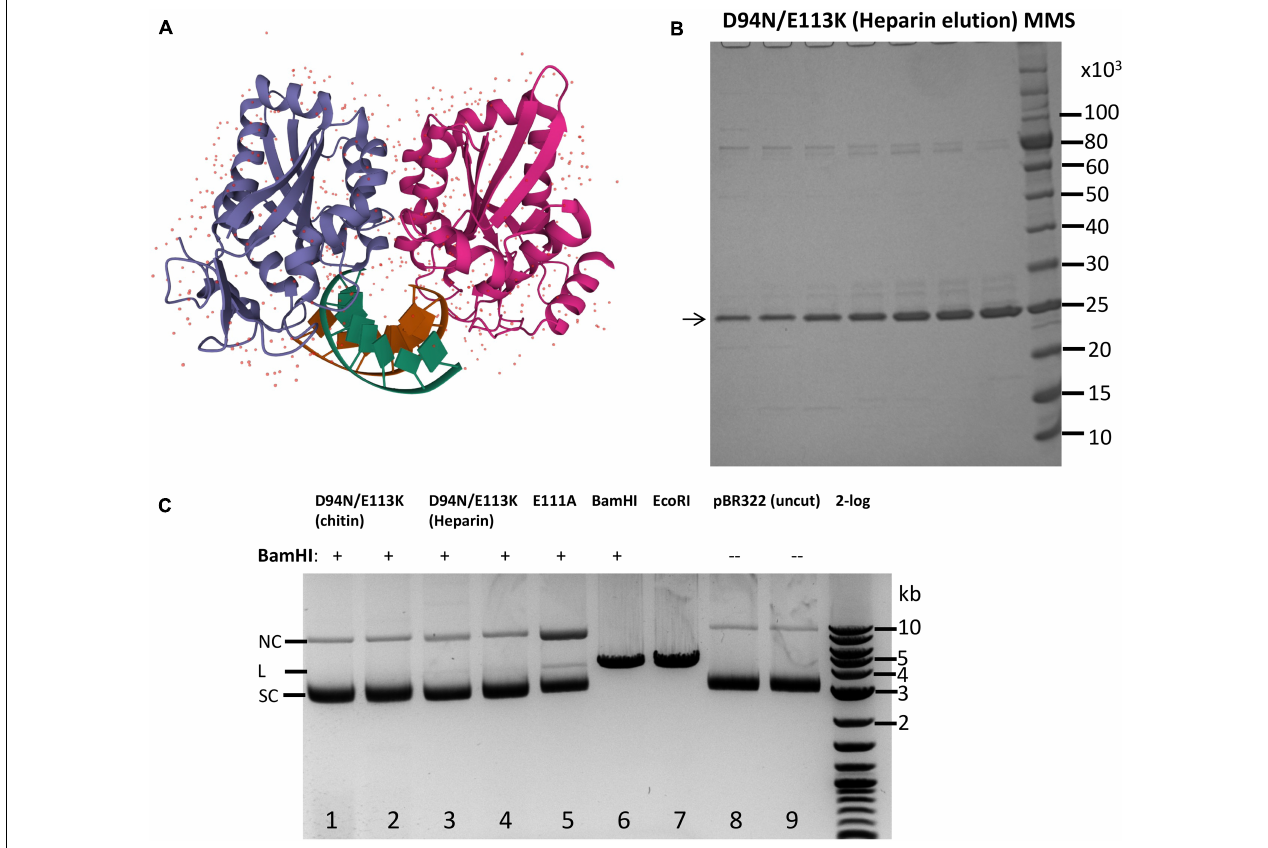
FIGURE 1 | Purification of catalytic-deficient Bam HI mutant D94N/E113K and protection of Bam HI site by D94N/E113K against Bam HI restriction. (A) Crystal structure of a Bam HI dimer bound to the cognate site (tatGGATCCata) (PBD ID 1BHM). Two subunits of the Bam HI dimer are shown in purple and magenta colors, respectively. The DNA double helix is shown in green and brown colors. The small dots indicate water molecules in the dimer structure. (B) SDS-PAGE analysis of the purified Bam HI variant D94N/E113K ( ∼ 24.57 kDa). Eluted fractions from a heparin column (HiTrap Heparin 5 ml) were shown. MMS, protein molecular mass standard in Daltons (Da) (NEB). (C) Bam HI restriction digestion in the presence of D94N/E113K. Lanes 1–4, pBR322 (1 µ g, ∼ 7.1 nM) with a single Bam HI site was first incubated with D94N/E113K (0.5 and 1 µ g, ∼ 0.4 and 0.8 µ M) at 25 ◦ C for 15 min, and 5 U of Bam HI was then added to the bound complex and incubated at 37 ◦ C for 30 min. After restriction digestion, Proteinase K (1.6 U) was added and incubated at 37 ◦ C for 15 min to remove Bam HI and the mutant protein. Lane 5 is the same as in lanes 1–4 except a different Bam HI catalytic mutant (E111A, 1 µ g, ∼ 0.8 µ M) was used. In lanes 6 and 7, pBR322 was linearized by Bam HI (10 U) and Eco RI (10 U), respectively, in the absence of D94N/E113K. Lanes 8, TE (10 mM Tris–HCl, 0.1 mM EDTA) mock digestion; lane 9, uncut pBR322. 2-log, DNA size ladder (100 bp to 10 kb, NEB). SC, supercoiled DNA; L, linear DNA; NC, nicked circular DNA. The size of linear pBR322 is ∼ 4.4